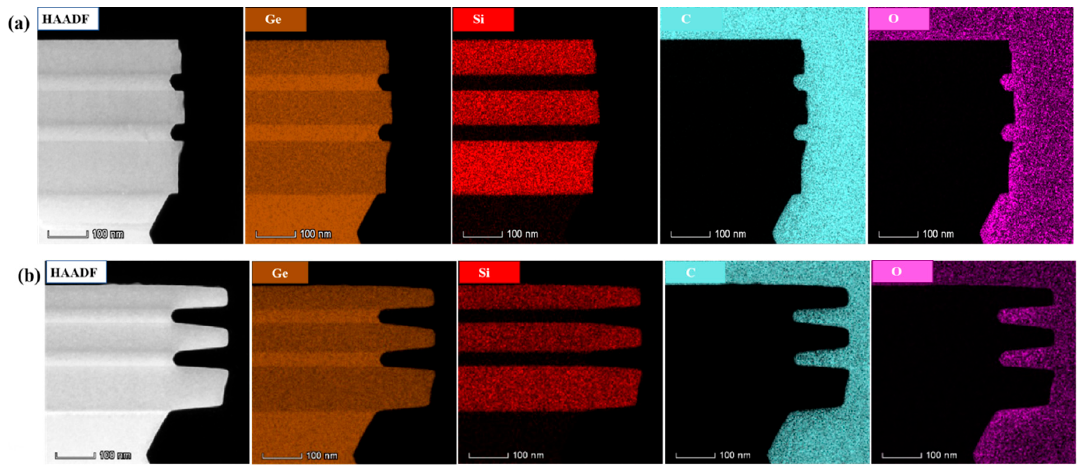
Figure 10. EDS mapping near etching regions with elements Ge, Si, C and O, ( a ) sample etching for 10 s with H 2 O 2 solution, ( b ) sample etching for 2 min with H 2 O 2 solution.